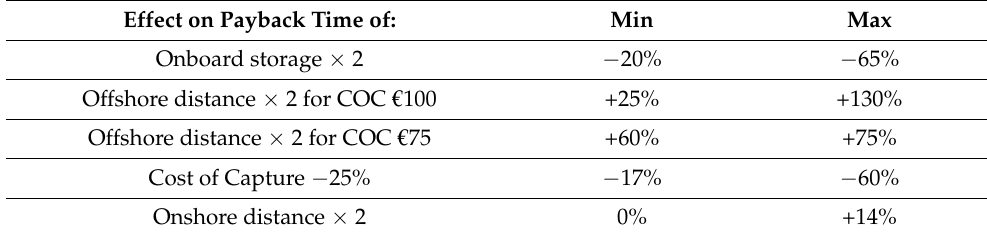
Table 3. Effect on payback time from variations of scenario parameters. Effect on Payback Time